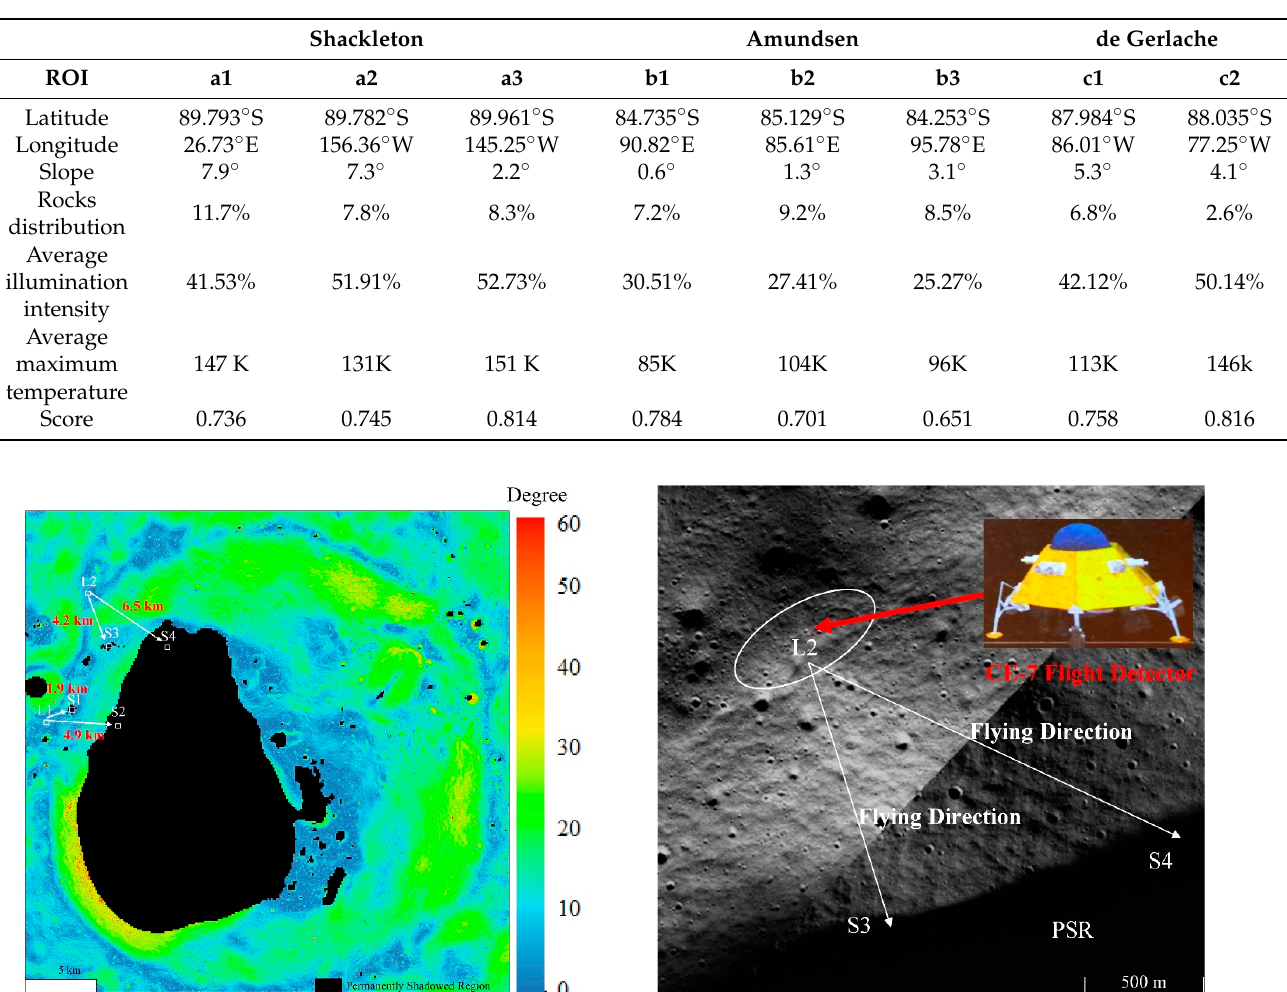
Table 5. The evaluation index parameters for the red box areas in Figure 17.